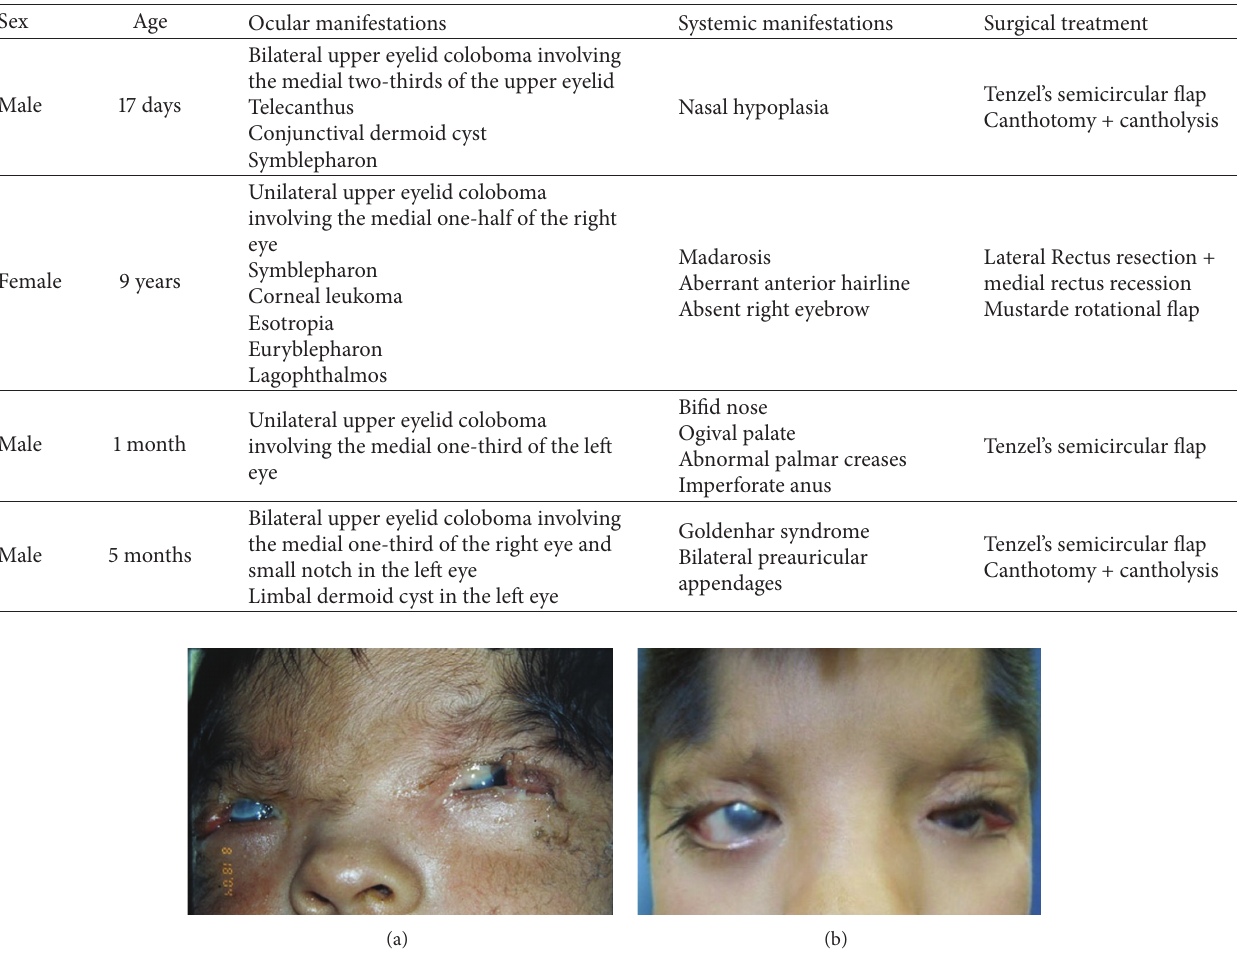
Figure 1: (a) Case 1 with 17 days old. The patient has bilateral eyelid coloboma and bilateral corneal erosions due to exposure. (b) Case 1. At the age of 9 years after